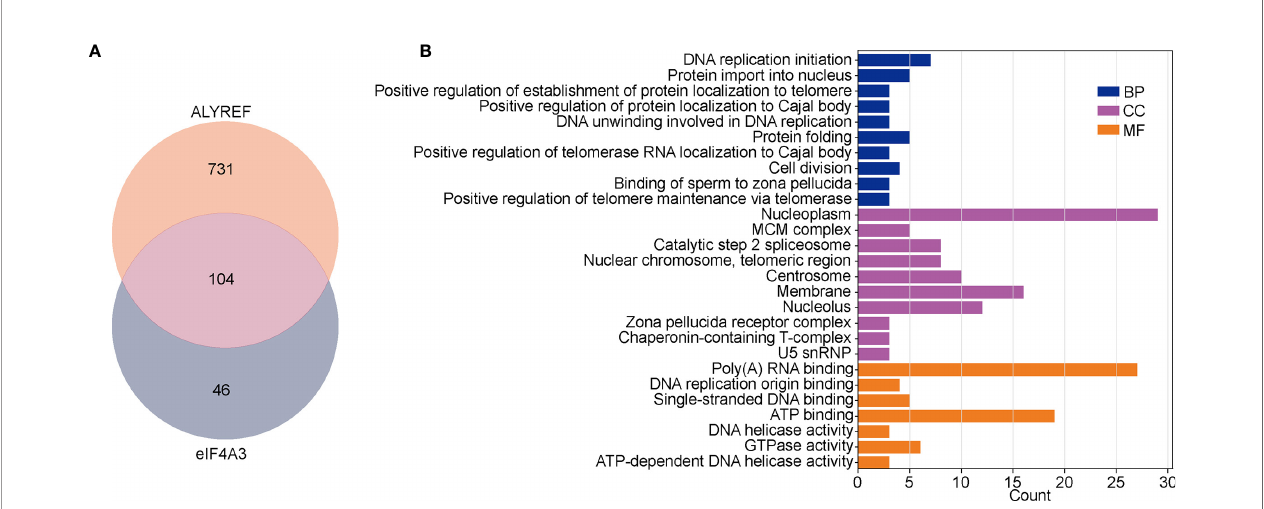
FIGURE 5 | Analysis of co-related genes and pathways between ALYREF and eIF4A3. (A) The differentially expressed genes for both ALYREF and eIF4A3, and the 104 in common between them. (B) The Gene Ontology analysis indicated that ALYREF and eIF4A3 have many co-related pathways in common.